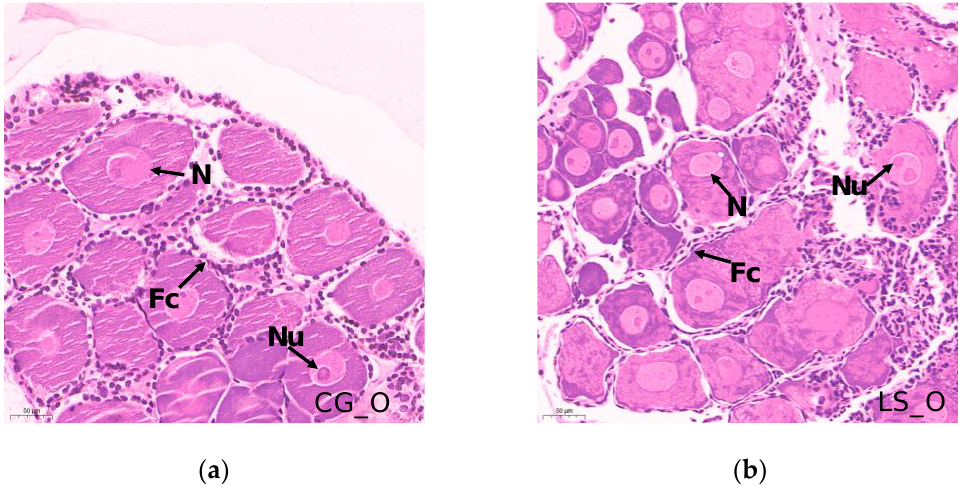
Figure 2. Histological sections of the ovarian status of E. carinicauda : ( a ) CG_O group; ( b ) LS_O group. Bar: 50 µm. Abbreviations: N, Nucleus; Nu, nucleolus; Fc, follicular cell. Bar: 50 µ m. Abbreviations: N, Nucleus; Nu, nucleolus; Fc, follicular